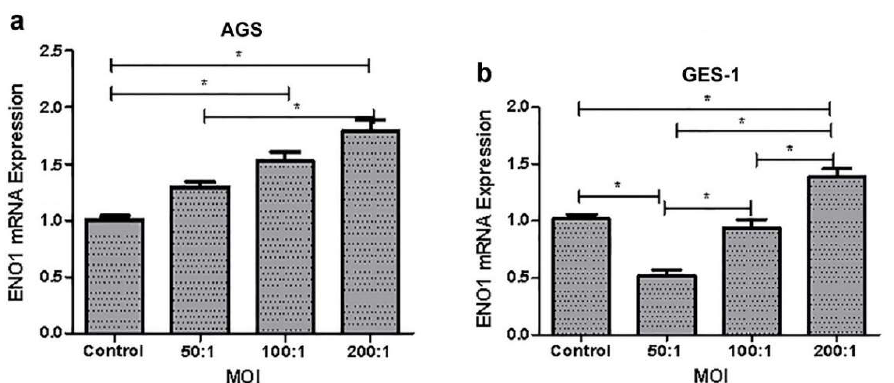
Figure 2. ENO1 mRNA levels in the AGS ( a ) and GES-1 ( b ) cells co-cultured with H. pylori for 24 h at a variety of MOIs. On comparing groups in pairs, the statistical standard was adjusted to α´ = 0.008. *, p < 0.008.